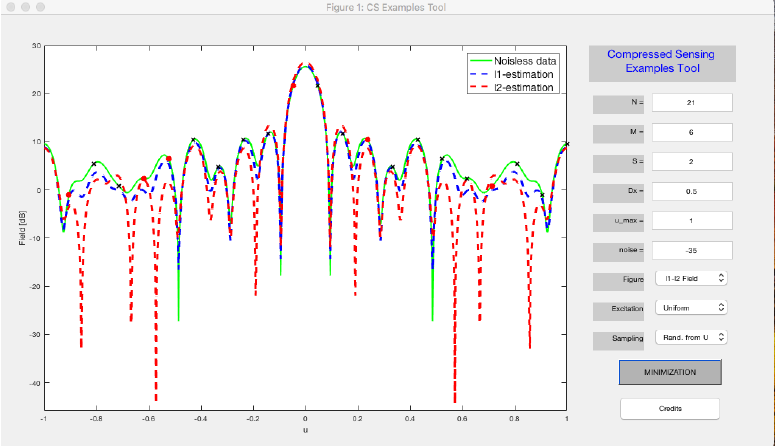
Figure 15. CS/SR reconstruction from − 35 dB level noise affected data; N = 21 radiating elements, S = 2 failures, and M = 6 measurement points (plotted as red circles in the figures); figure from the CS Examples Tool